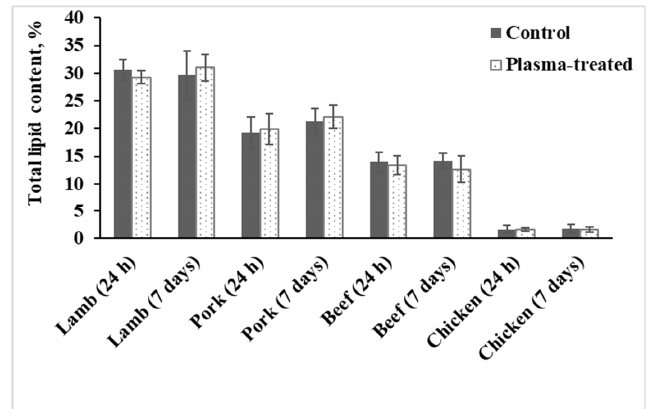
Figure 5. Lipid content in control and plasma-treated meat samples.